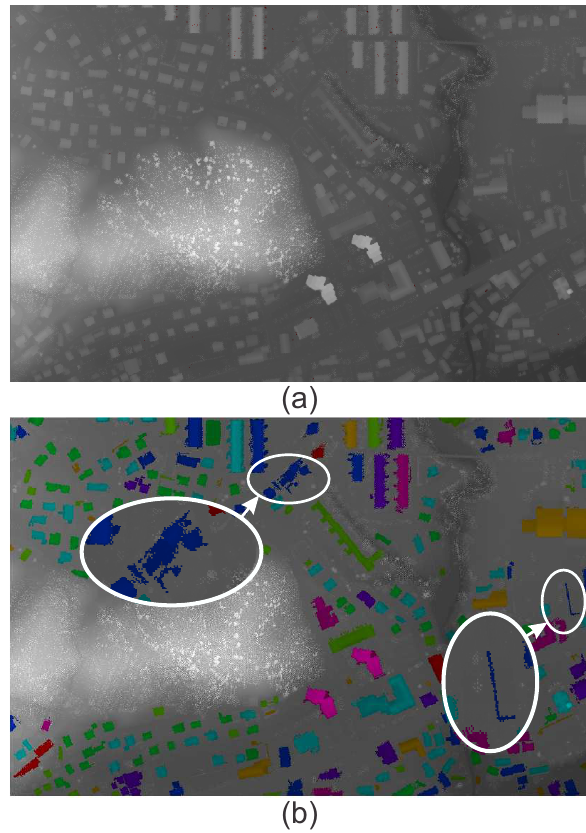
Figure 2: Detection of flat regions in (a) denoised grid g and (b) ( g ) , colour-coded according to i , the results obtained based on δ Λ (cid:126)λ where (cid:126)λ = { 0 , 50 , 100 , ..., 25000 } was used. Two typical errors are highlighted. In the left case, points from the neighbouring vegetation are accepted as building points whilst, in the right case a brick wall with a planar top surface is accepted. Table 1: Parameters used for buildings-extraction from LiDAR test